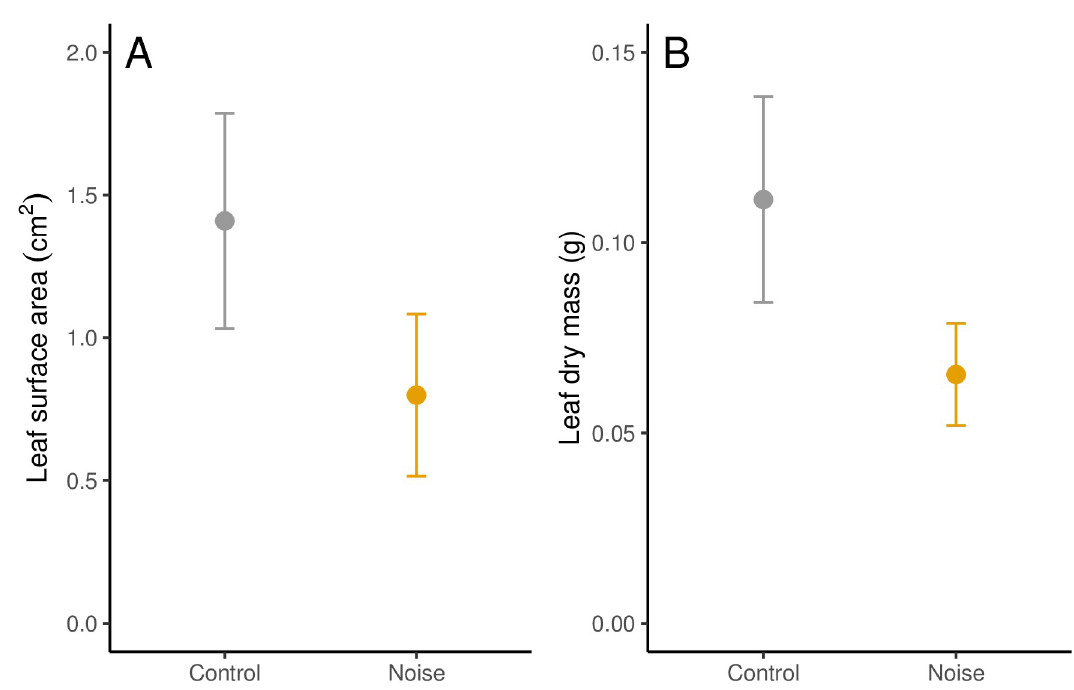
Fig 2. Mean ( ± SD) of foraged leaf fragment A) surface area (cm 2 ) and B) dry mass (g) by A . octospinosus under noise and control treatments.